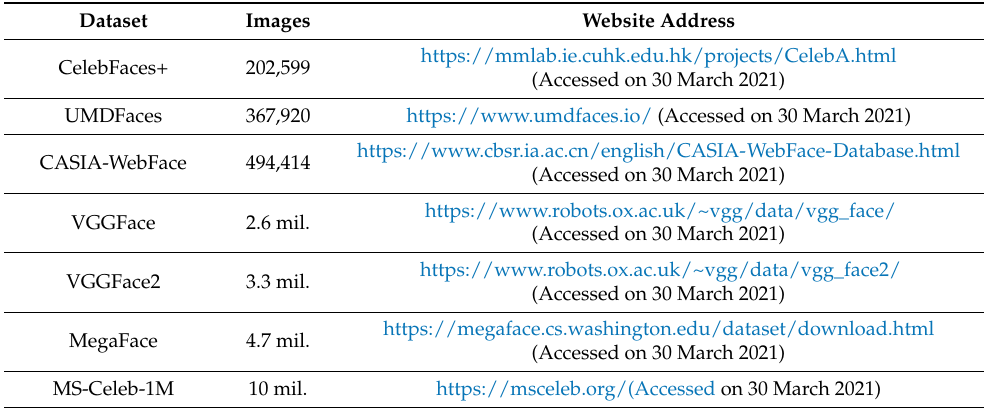
Table 2. Public large-scale face datasets.